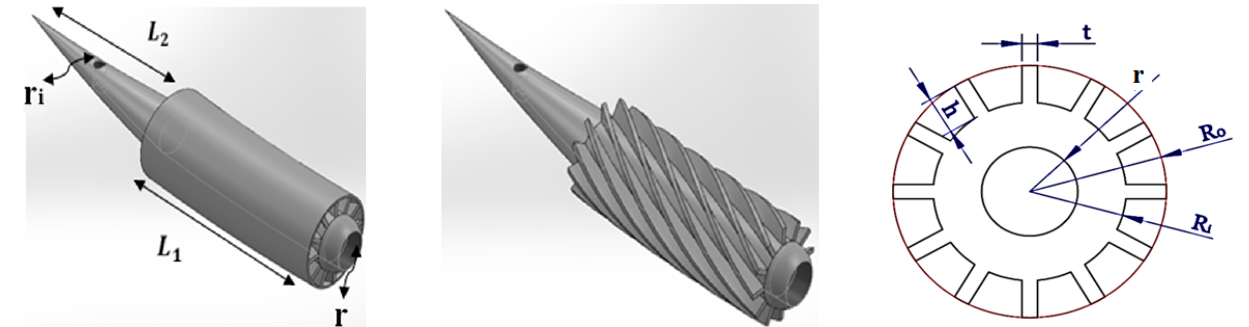
Figure 1. The schematics of the geometries of the helical double pipe heat exchanger and employed swirl generator; ( a ) the 2D-view of the heat exchanger’s cross-section with geometric factors, and ( b ) the 3D-view of the computational domain.